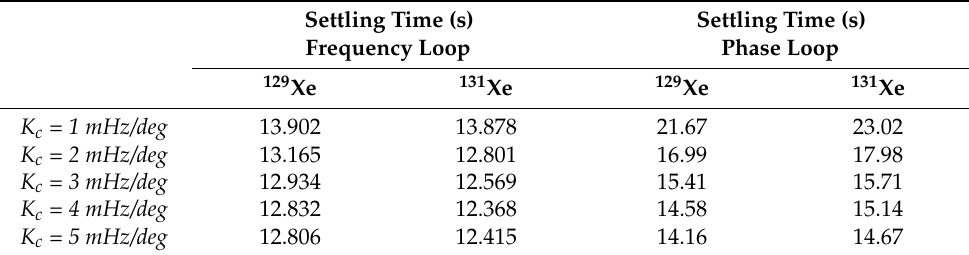
Figure 7. Experimental results of increasing bandwidth of the LADRCs. ( a , c ) are the performance of the 129 Xe, and ( b , d ) are the loop of 131 Xe. Both kind of isotopes were driven synchronously, and the influence of the parameter K c was specified. Table 3. Detailed Settling Time of the Tested Method in Figure 7.